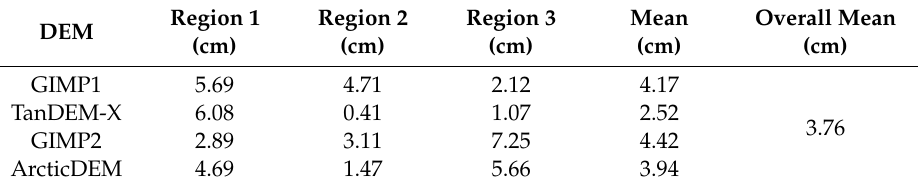
Table 4. The standard deviations of the sampling points in the same grid.